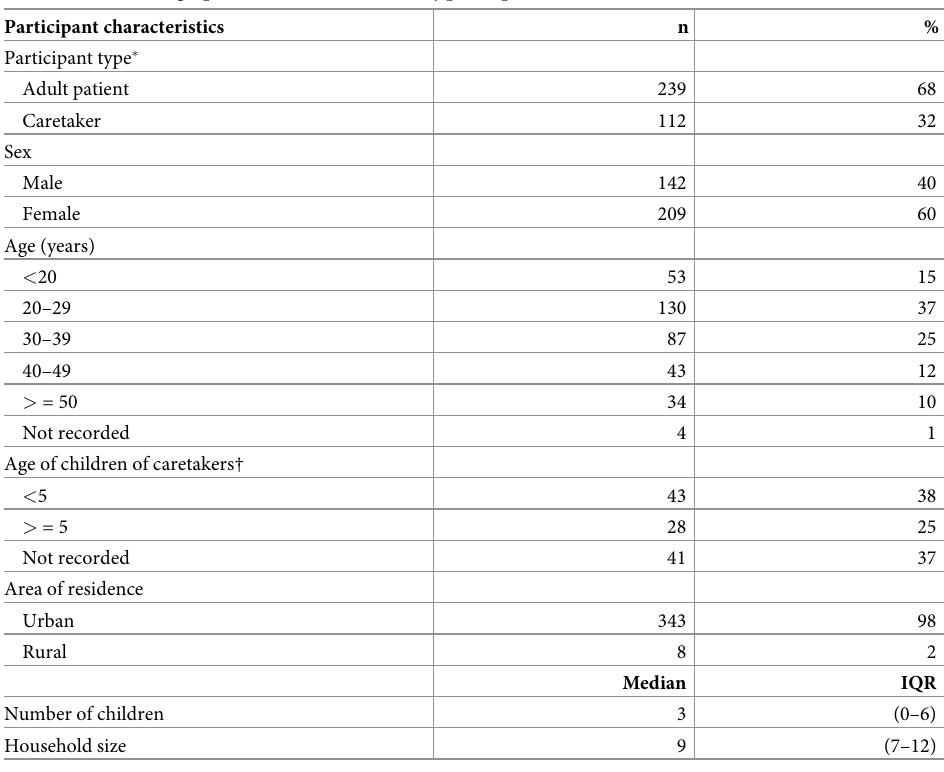
Table 2. Socio-demographic characteristics of survey participants (n =